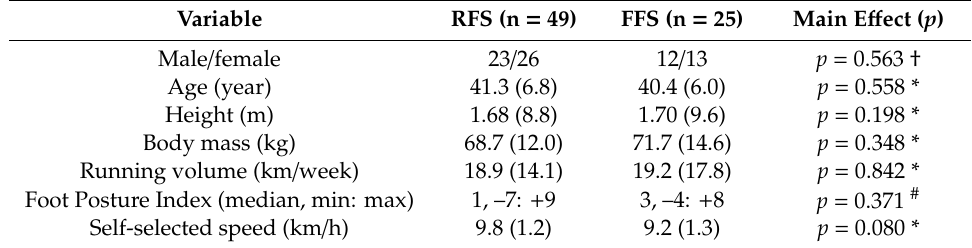
Table 1. Mean (standard deviation) demographics for naturally FFS and RFS